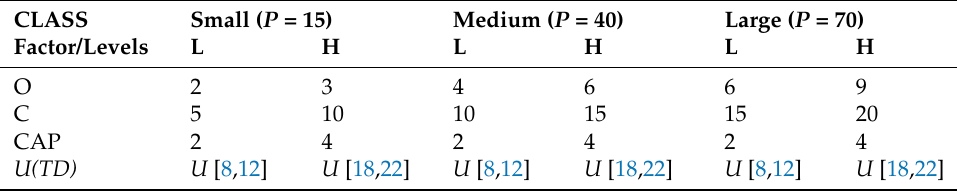
Table 4. Classes of problems and related